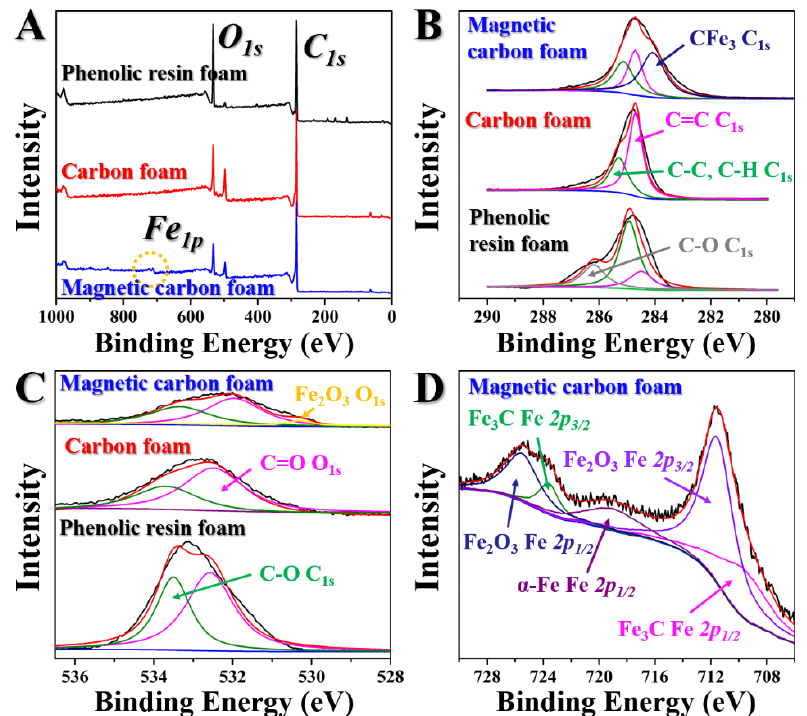
Figure 3. ( A ) Total XPS spectra for phenolic resin foam, carbon foam, and magnetic carbon foam. ( B–D ) High-resolution XPS spectra of C 1s , O 1s , and Fe 2P for phenolic resin foam, carbon foam, and magnetic carbon foam, respectively.